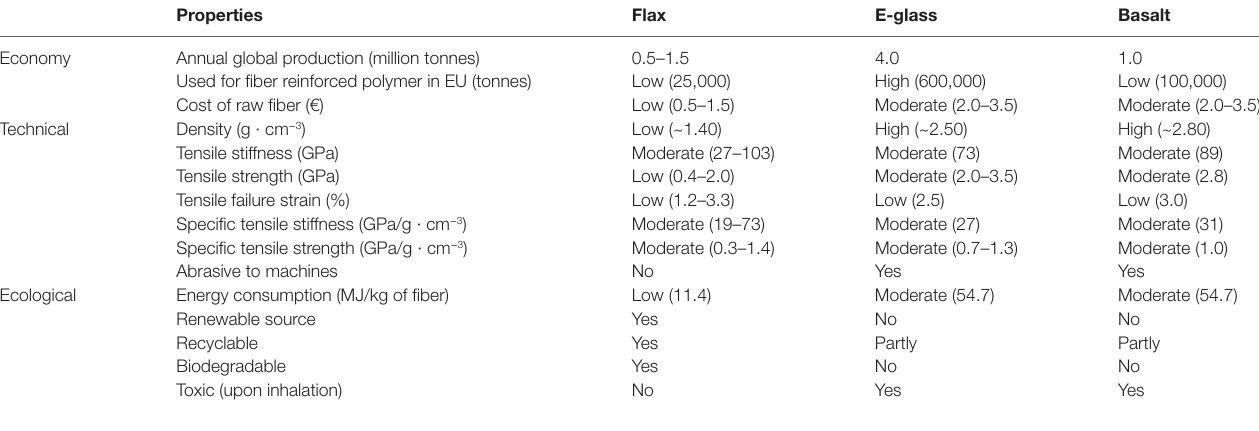
TaBle 3 | Comparison between plant-based flax fiber and E-glass (Le Duigou et al., 2011; Shah et al., 2013; Yan et al., 2014a; Fiore et al., 2015) (BasaltToday, 2017; Available from: